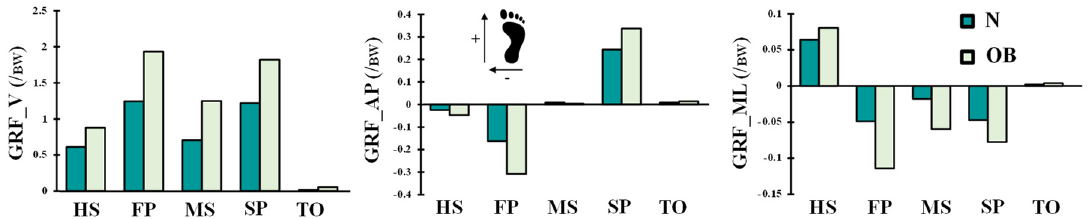
Figure 4. Vertical, anterior, and lateral ground reaction force (GRF) components at different stance phase times for normal-weight (N) and obese subjects (OB). Loads were normalized to the BW = 732.365 N of the female subject of our FE model.